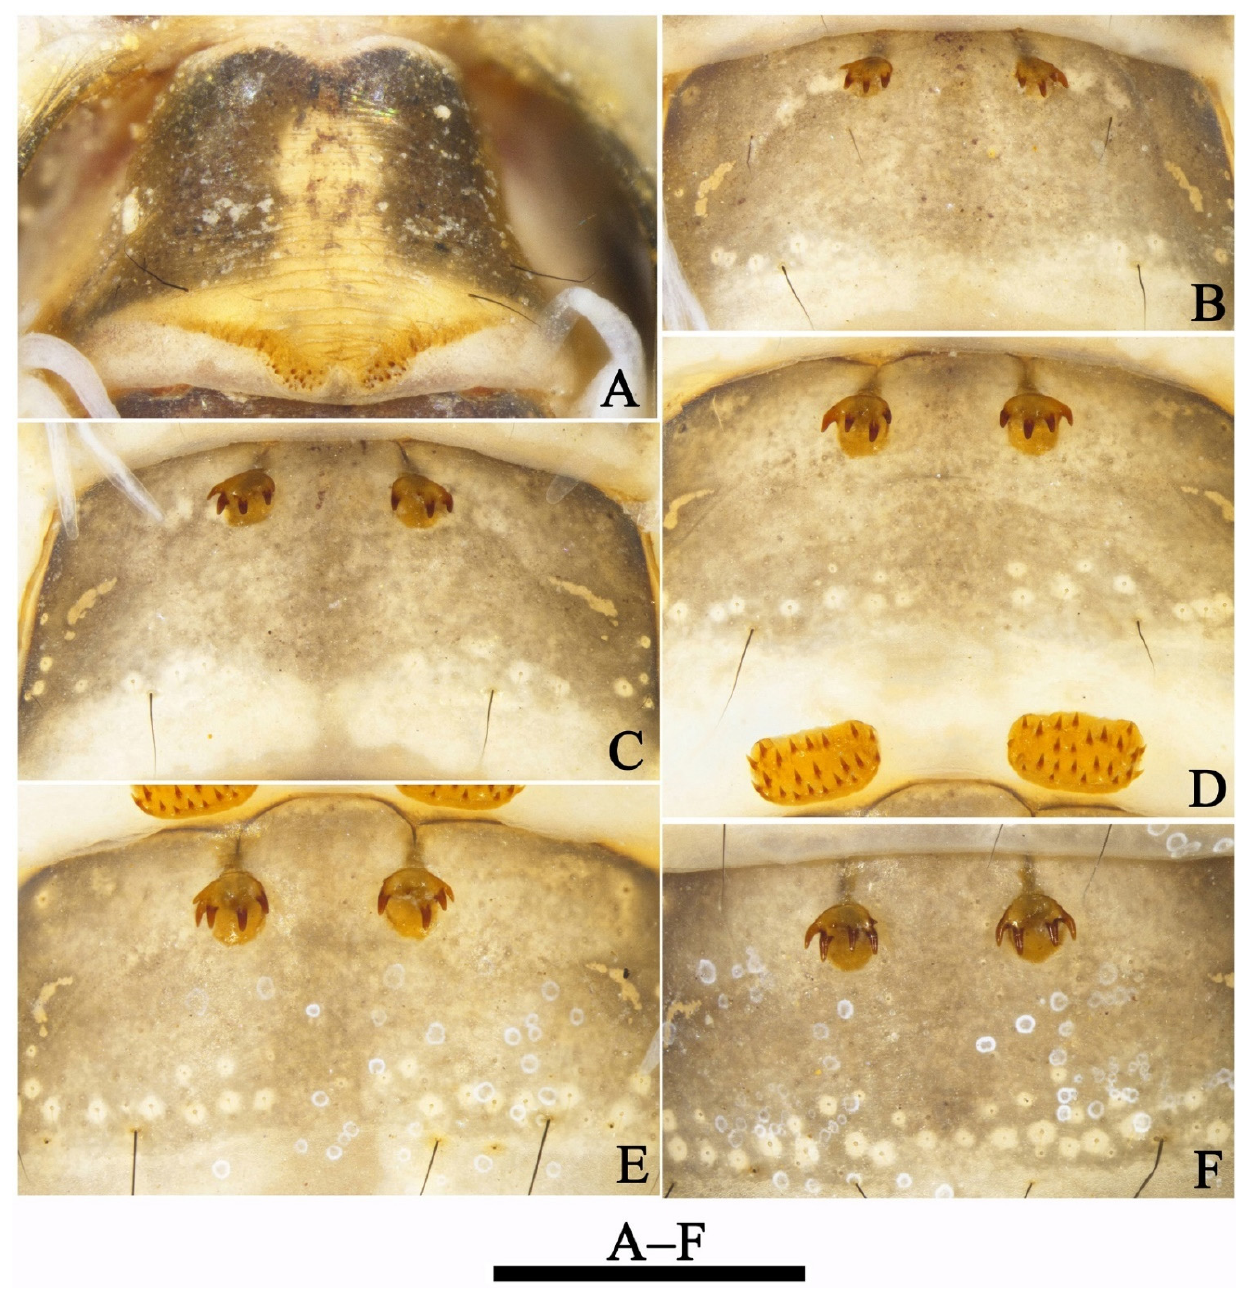
Figure 13. Limnephilus deqianensis n. sp. , pupa hook plates. ( A ) Ip; ( B ) IIIa; ( C ) IVa; ( D ) Va and Vp; ( E ) VIa; ( F ) VIIa. IIIa–VIIa = anterior hook plates of terga III–VII; Ip and Vp = posterior hook plates of terga I and V. Scale bar: 1